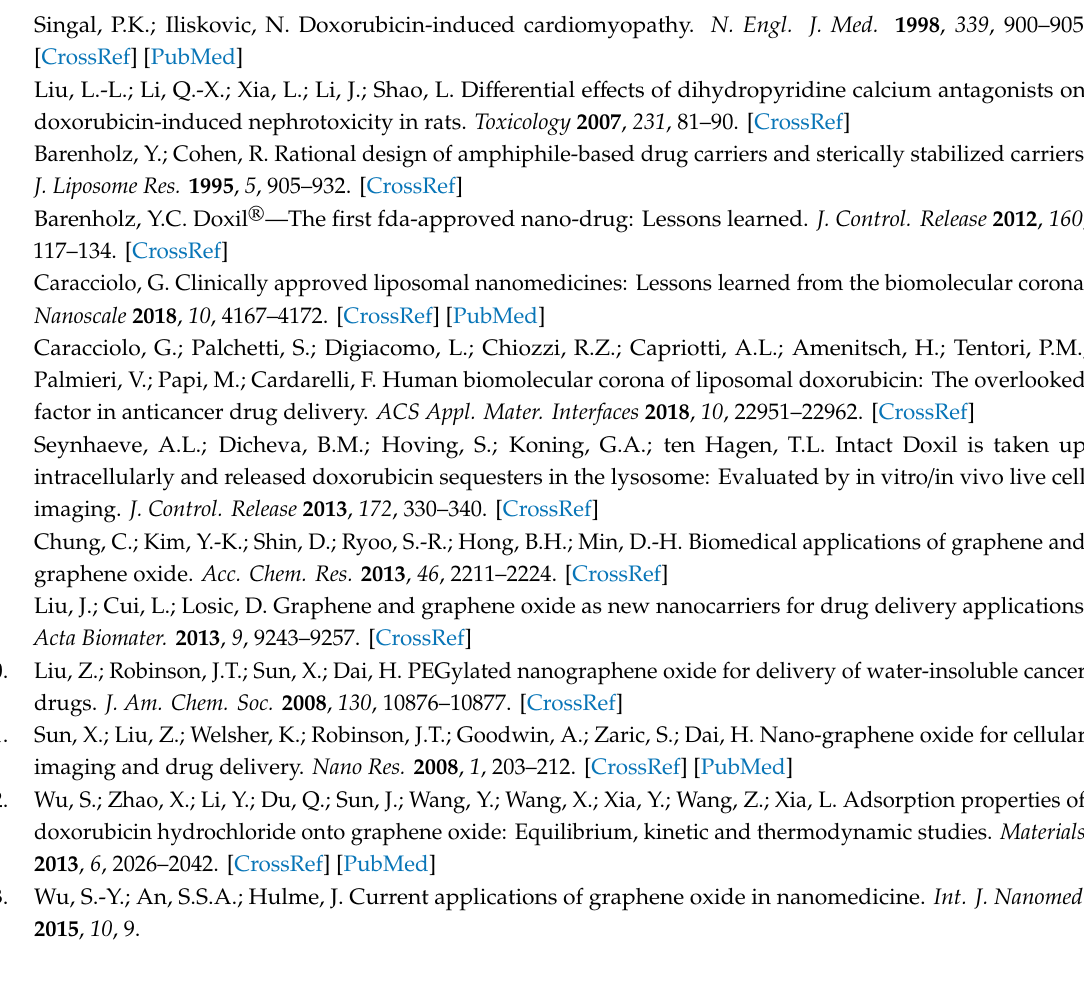
Figure S1: Absorbance spectra of doxorubicin (DOX) at several known concentrations. DOX calibration curve was generated from absorbance values at λ = 480 nm, Figure S2: D H of GO / DOX complexes as a function of pH solution, Figure S3: D H intensity-weighted distribution of pristine GO and GO / DOX complexes, Figure S4: The experimental lifetime of DOX in aqueous solution, the experimental lifetime of pristine graphene-oxide (GO) in aqueous solution and the experimental cluster of